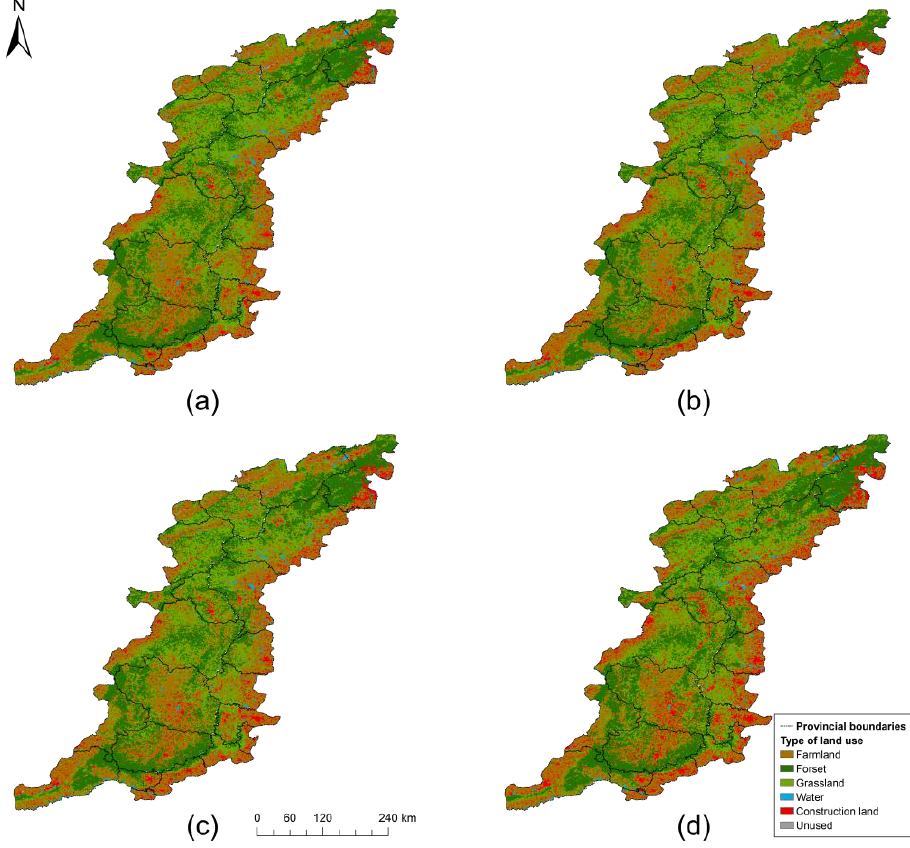
Figure 3. Spatial distribution of land use in the Taihang Mountains in different periods: ( a ) 2005; ( b ) 2010; ( c ) 2015; ( d ) 2019. (The data were obtained from the Resource and Environment Science and Data Center (https://www.resdc.cn/ (accessed on 28 January 2022))). Table 3. Land use change in the Taihang Mountains from 2005 to 2020 (unit: area-km 2 ,